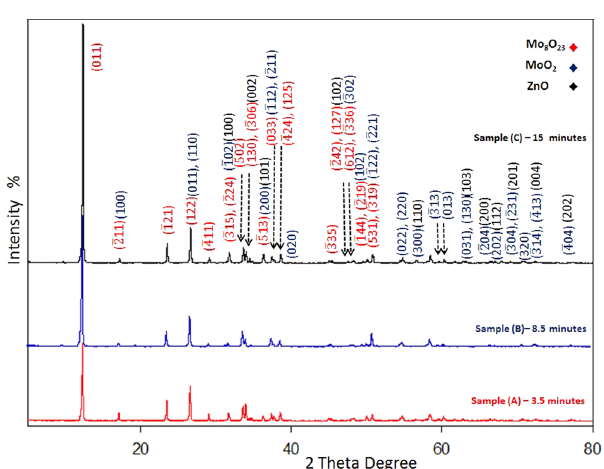
Figure 19. XRD Patterns for three samples of the nanocomposite that were picked up at different intervals (3.5, 8.5, and 15 minutes) after starting of